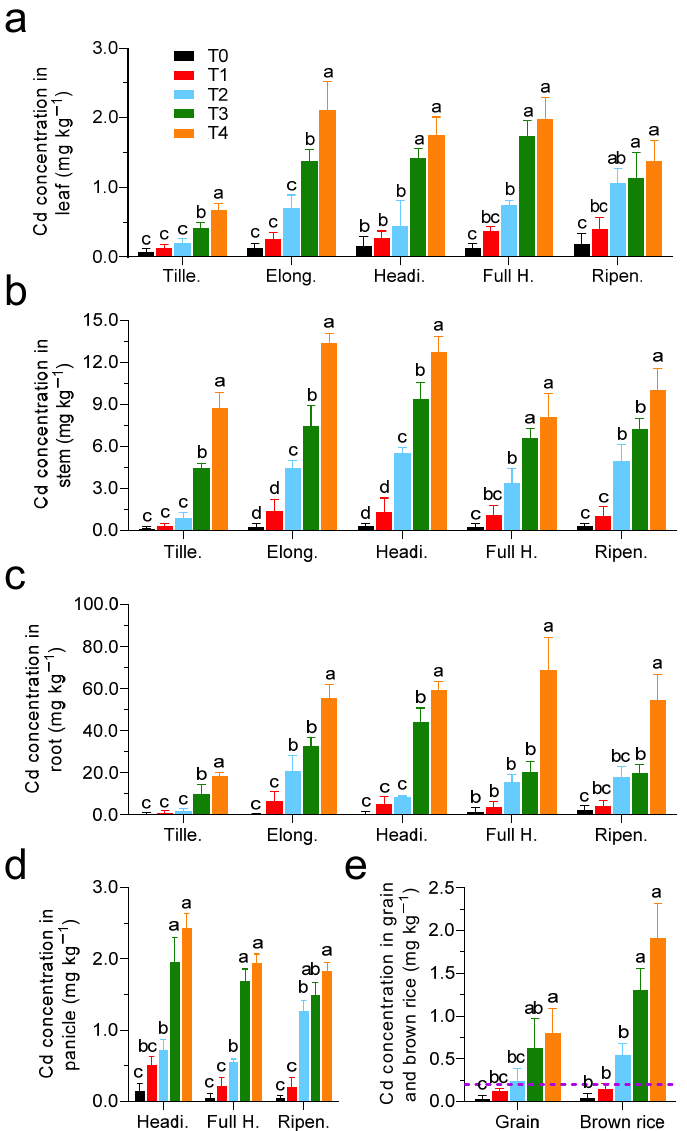
Figure 3. The dynamic changes of Cd concentration in rice tissues of different treatments: ( a ) leaf; ( b ) stem; ( c ) root; ( d ) panicle; ( e ) grain and brown rice. The purple line (0.2 mg kg –1 ) represents limit standard of Cd in brown rice of China according to the GB 2762-2017. Different lowercase letters represent significant levels of Cd content among different treatments ( p < 0.05).